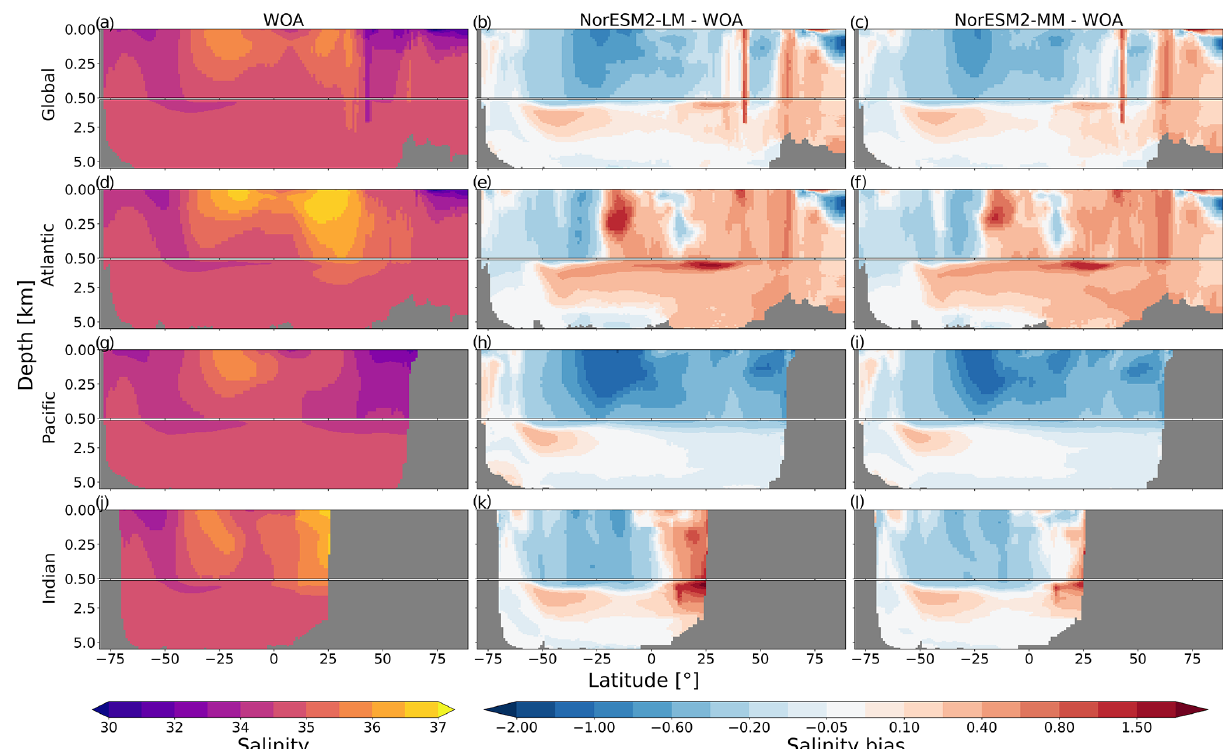
Figure 11. As in Fig. 10 but for the zonal-mean bias in salinity.